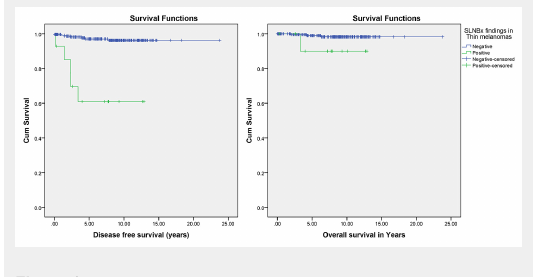
Effect of sentinel lymph node biopsy (SLNBx) result on disease-free and overall survival in intermediate melanoma (p <0.001 and p <0.001,